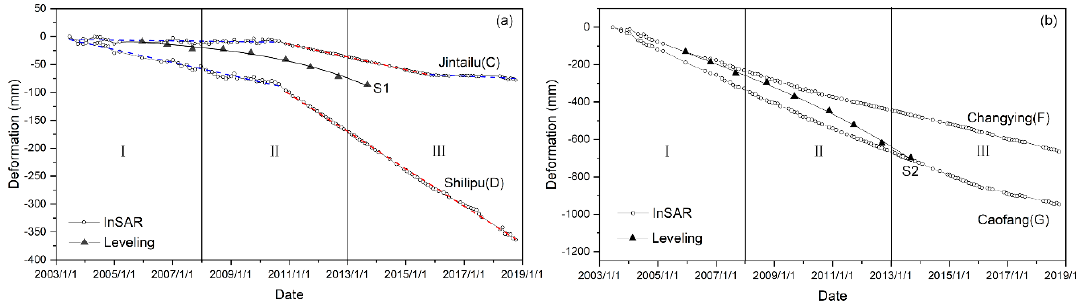
Figure 7. Piecewise linear fitting of subway station subsidence time series. I: Early construction period, II: Construction period, III: Operation period. ( a ) Jintai Road Station and the Shilibao Station, located at the edge of the subsidence center (DBL). ( b ) Caofang Station and Changying Station, located near the subsidence center (DBL). The black triangles indicate the level monitoring values near the site, and the black line is the trend line fitted according to the level monitoring.